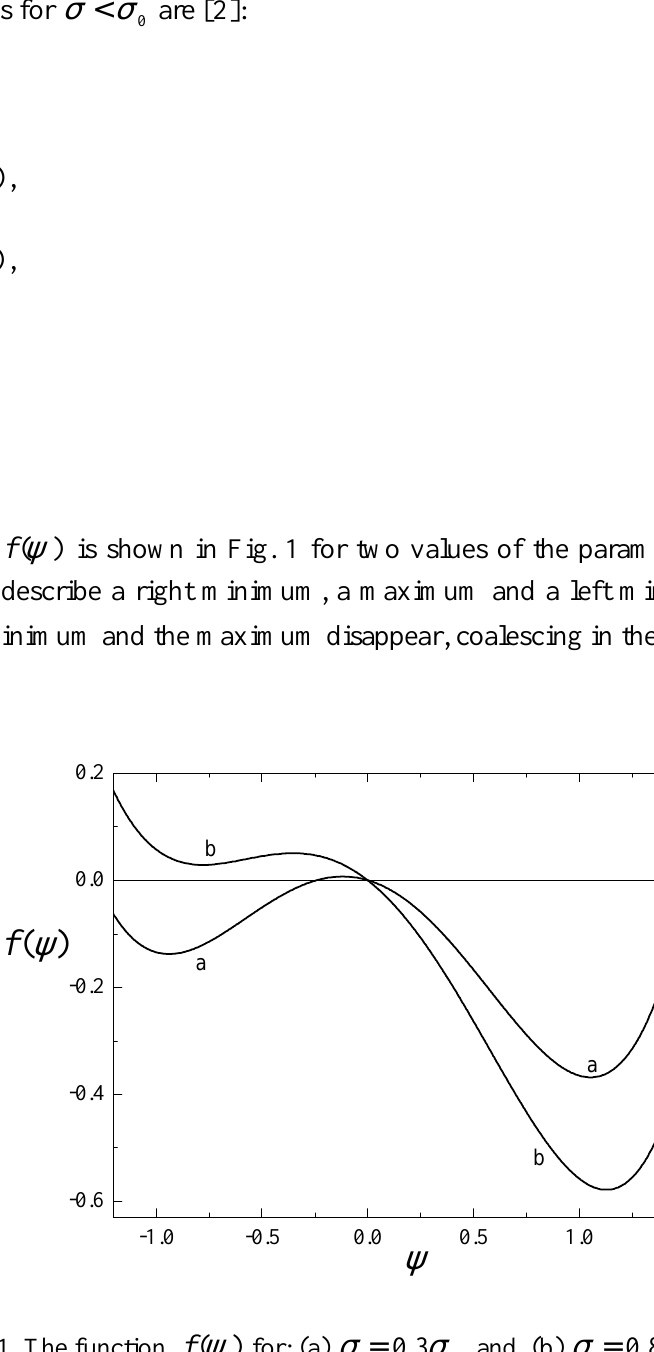
Fig. 1. The function )( y f for: (a)